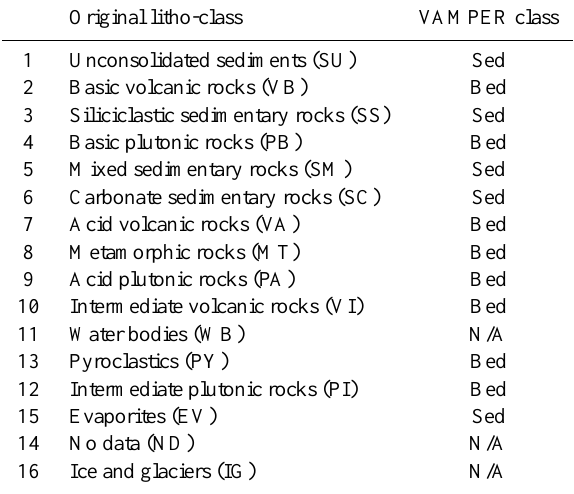
Table 3. The original lithological classification from Hartmann and Moosdorf (2012) and the reclassification scheme used for the EC- Bilt